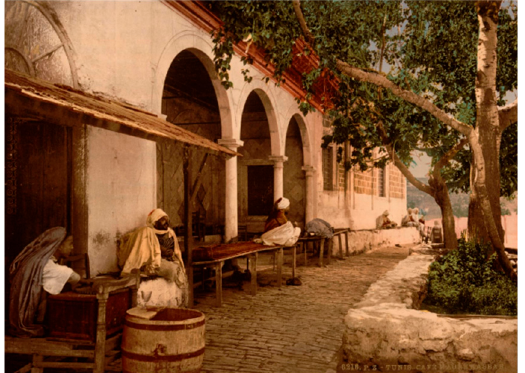
Figure 3. Traditional coffee place, Tunis, 1899 (data source: Bibliotheque numérique mondiale: https://www.wdl.org/fr/ (accessed on 7 January